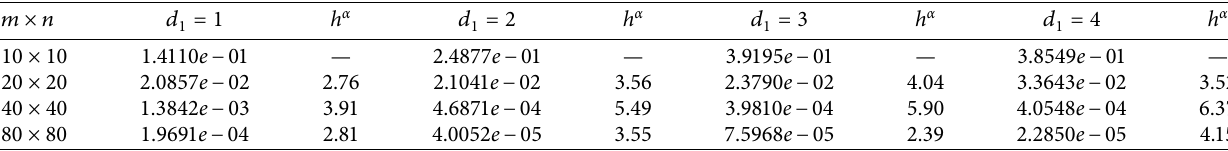
� 7 for Example 2. 2